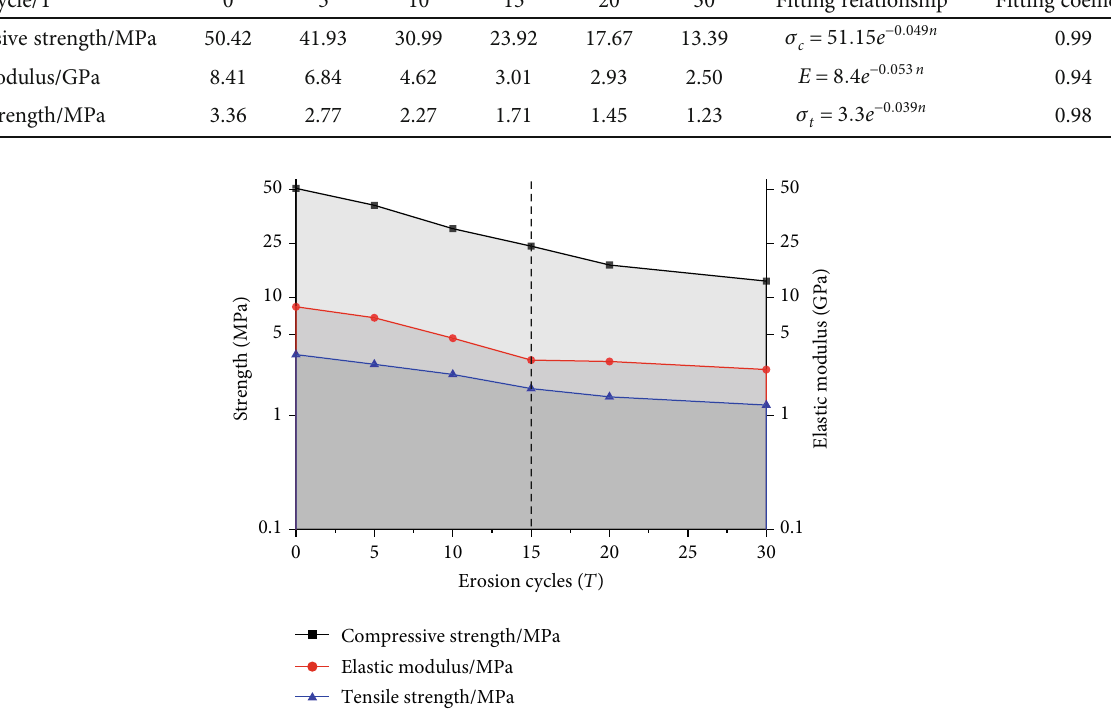
Table 2: Results of sandstone mechanical parameters after di ff erent erosion cycles. Erosion cycle/T